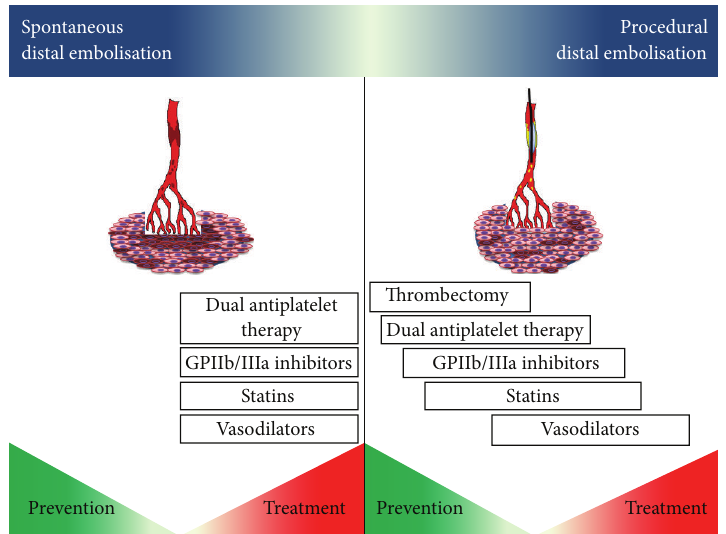
Figure 4: Prevention and treatment of spontaneous and procedural distal embolisation. Main mechanical and pharmacological options to treat and prevent distal embolisation in native vessels are reported according to their contribution in dealing with both spontaneous and procedural distal embolisation. Notably since spontaneous distal embolisation has already occurred or is ongoing at admission, pharmacologicalstrategiesareadoptedwithanonly“therapeutic”intentioninordertoreducetheimpactofemboliseddebrisonmyocardium. On the contrary the same drugs have a double role, preventive and therapeutic, in case of procedural distal